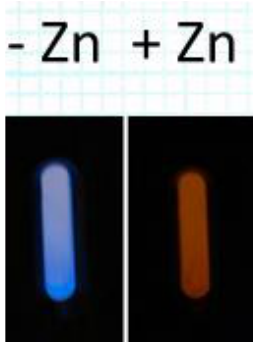
Figure 4. Photographs of furimazine-induced bioluminescence of apoNanoLuc-CA (-Zn 2+ , left) and holoNanoLuc-CA (+Zn 2+ . right), both in the presence of Lissamine Rhodamine sulfonamide taken with Nikon D100 SLR with 60 mm AF Micro-Nikkor 60 mm f/2.8, 2 s exposure, with no other illumination; Schott KV550 filter on right.